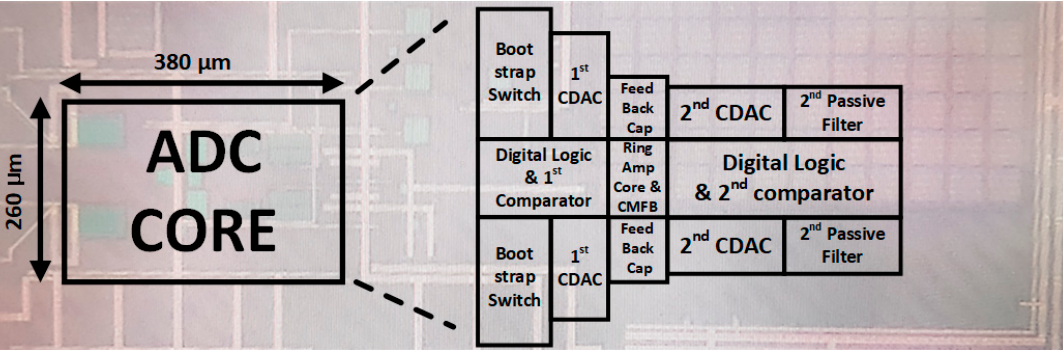
Figure 12. The die photograph of the ADC core.